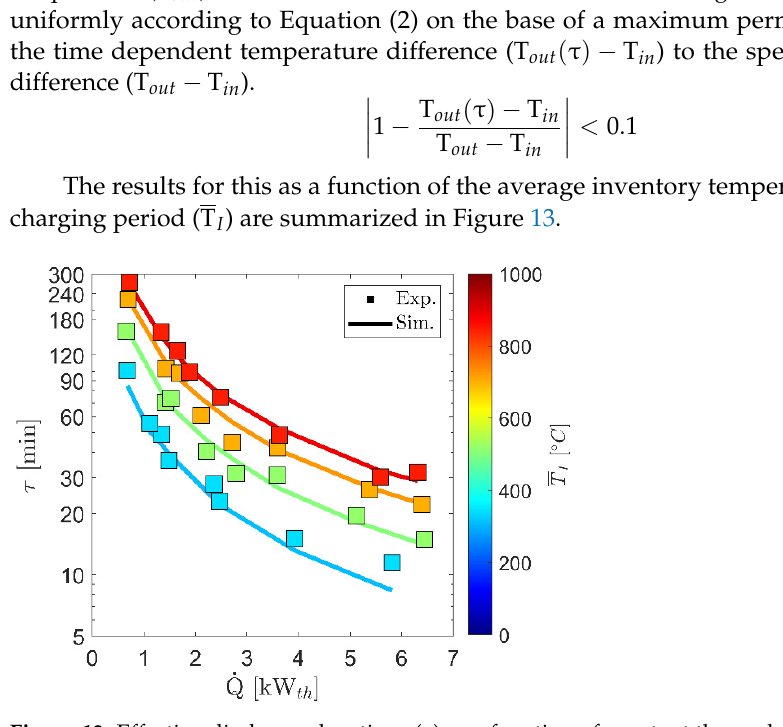
Figure 13. Effective discharge durations ( τ ) as a function of constant thermal discharge powers ( Q(cid:4662) ) and average inventory temperatures at the end of charging period ( T(cid:3365) (cid:3010) ).